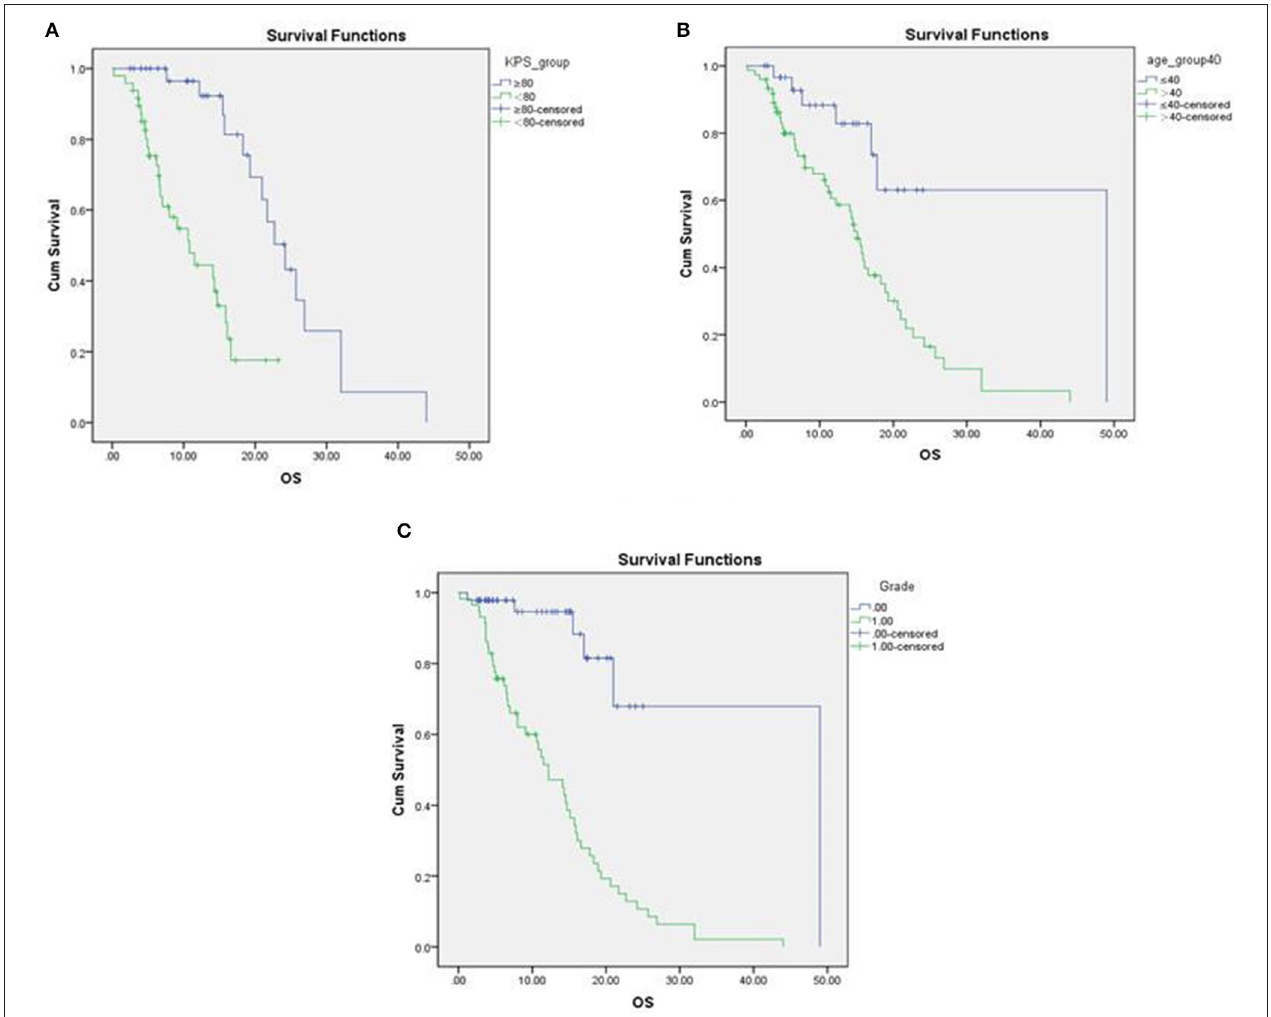
FIGURE 3 | Survival curves associated with preoperative KPS scores, age and grade of glioma. (A) The overall survival of the preoperative KPS score < 80 was significantly longer than the KPS score < 80; (B) Comparing the age was < 40 with the age was > 40 years old, the difference was statistically significant. The former has a longer life; (C) The overall survival of low-grade glioma and overall survival of high-grade glioma were compared. The low-grade glioma had a longer